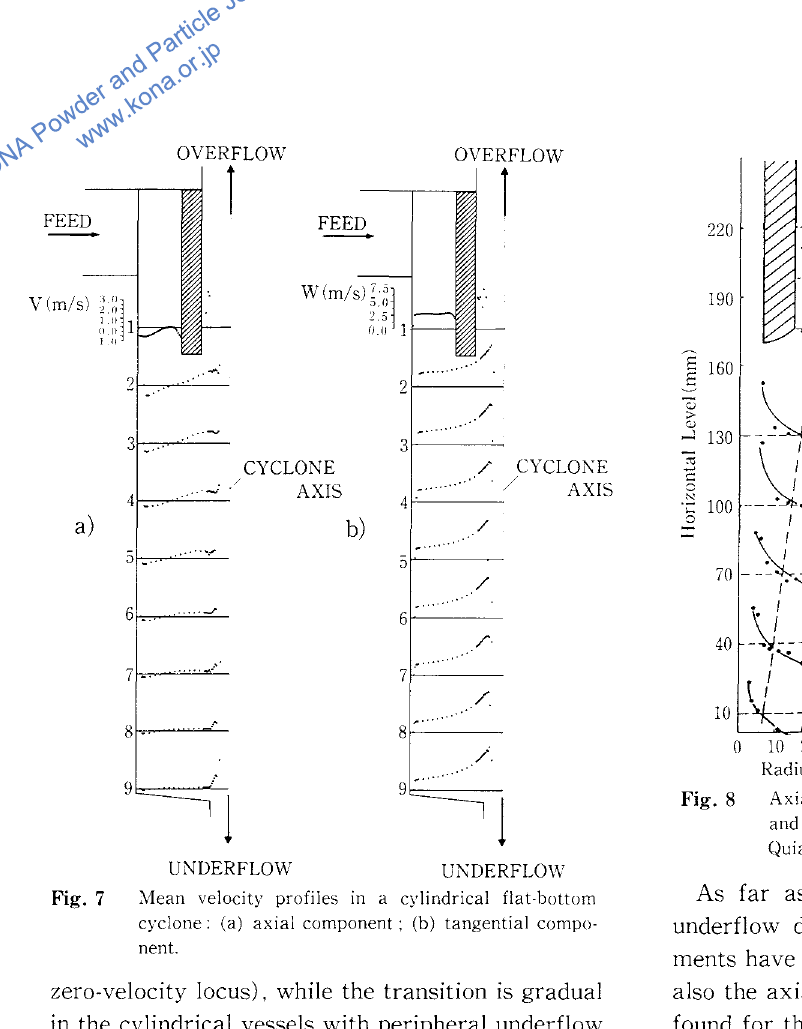
Fig. 8 Axial velocity profiles for a standard conical cyclone and a cyclone with a thicker wall vortex finder (Luo Qui an et a!..